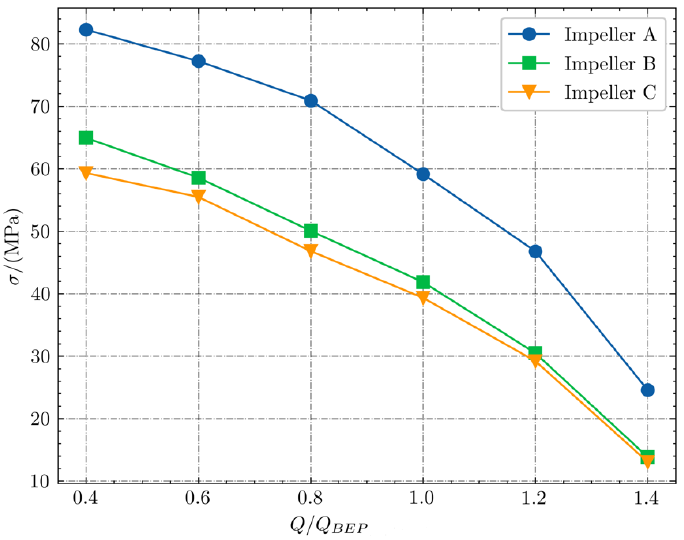
Figure 12. Curves of maximum equivalent stress of different impeller rotors with flow.